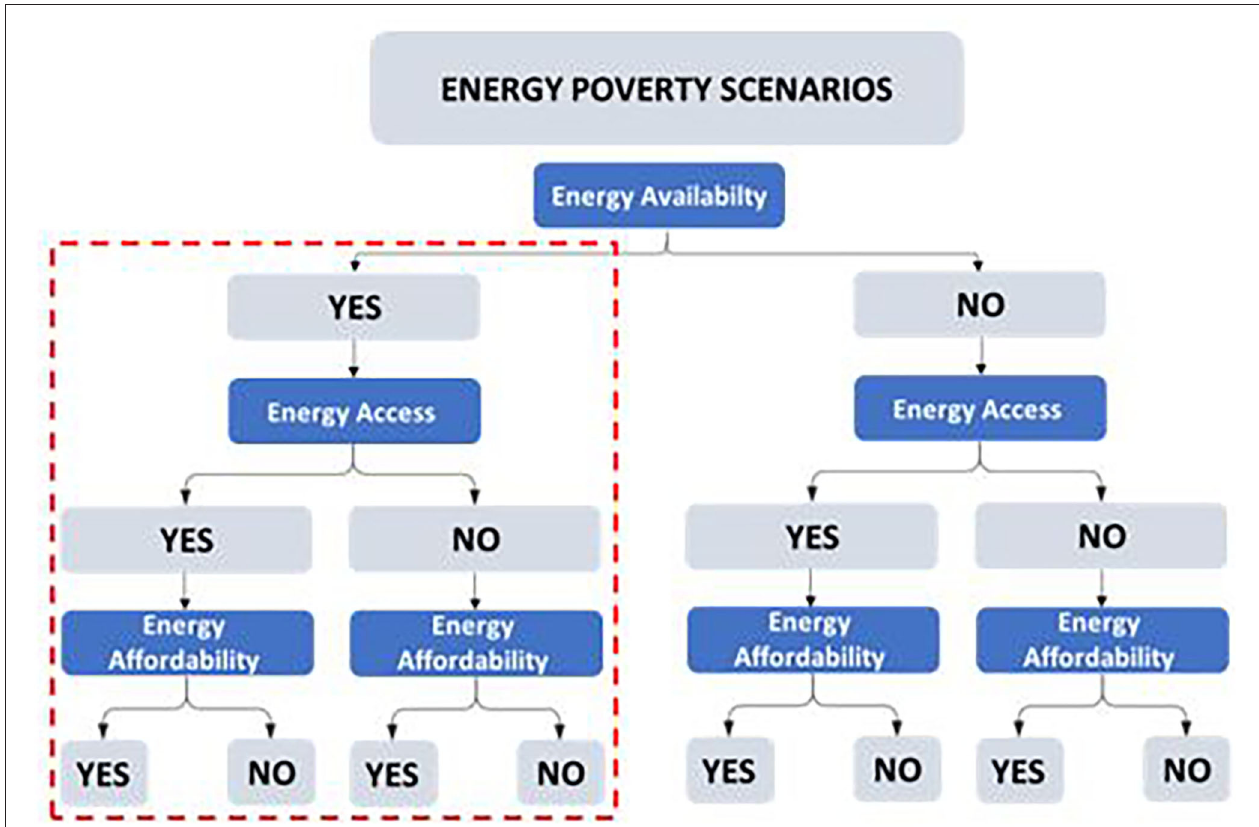
FIGURE 1 | Energy poverty scenario